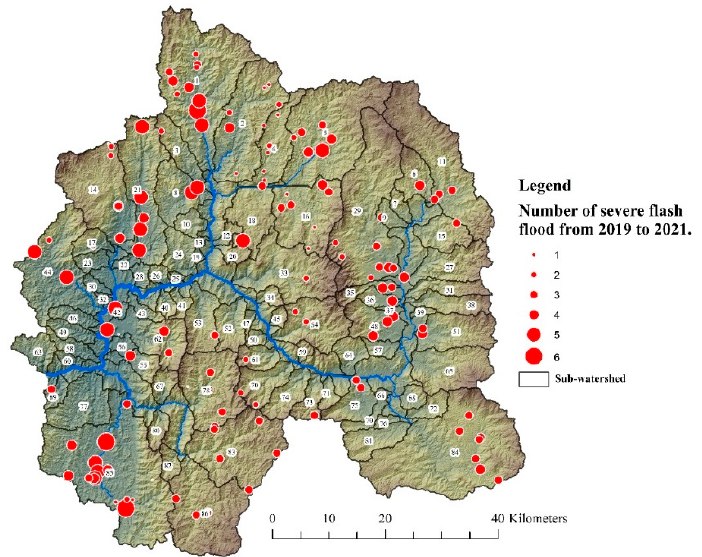
Figure 17. Number of severe flash flood event in the village during 2019 to 2021.